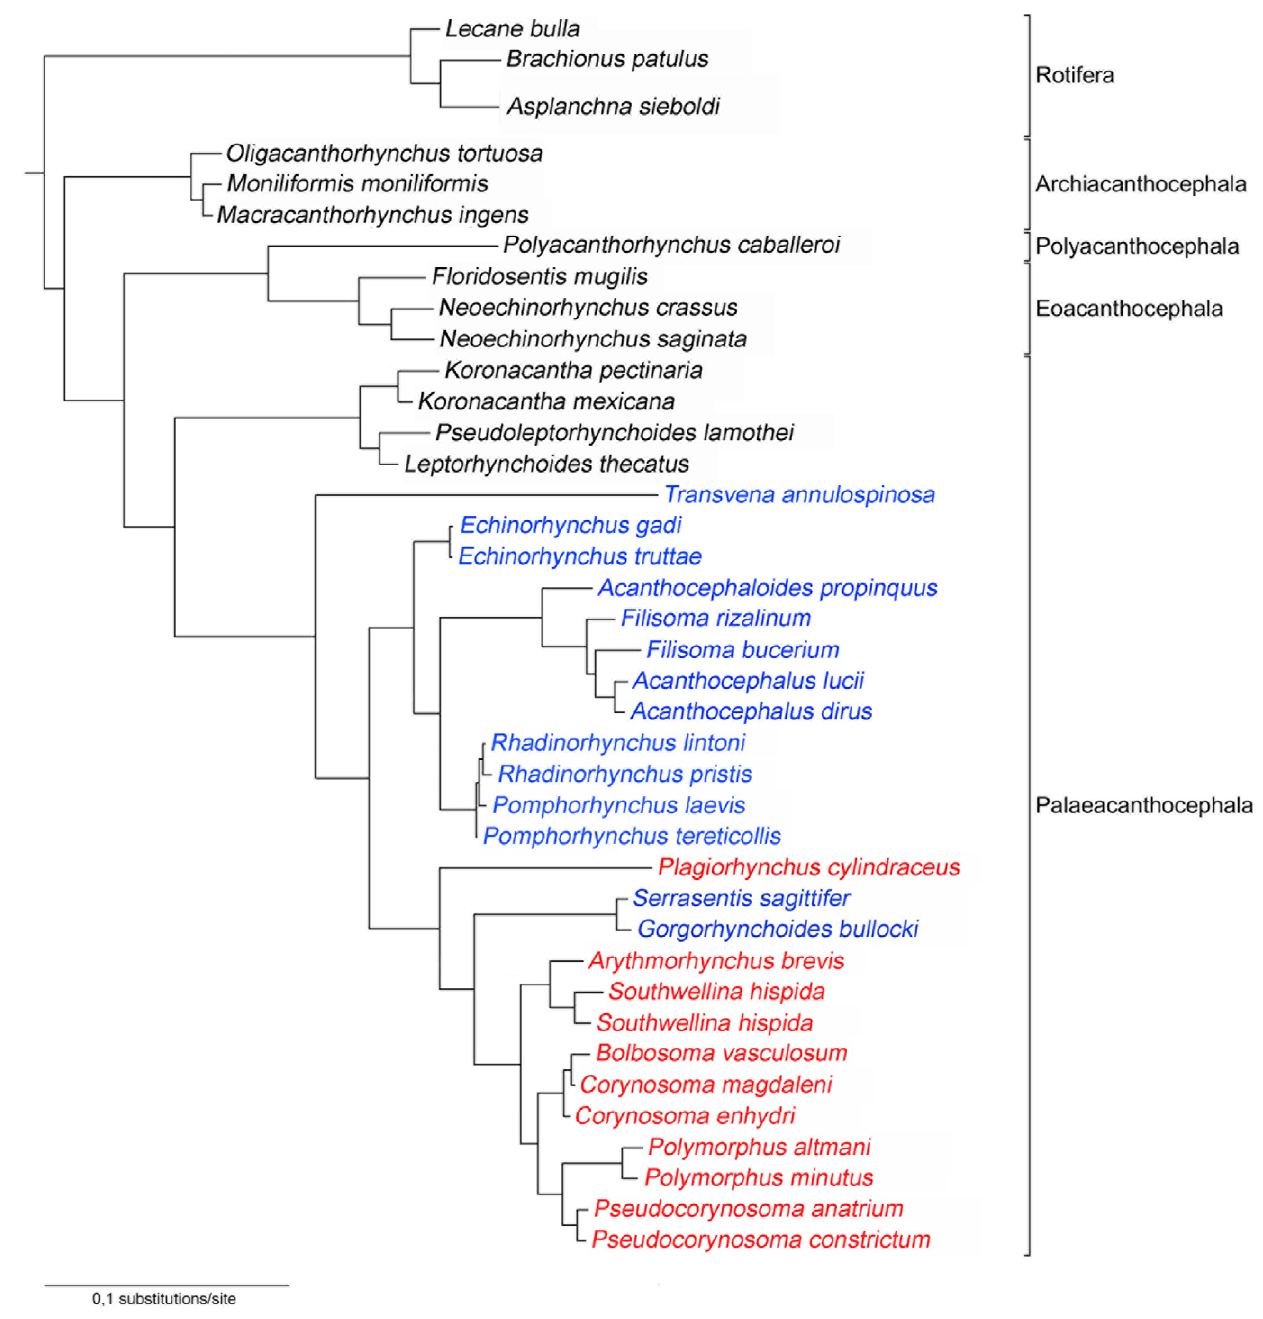
Figure 2. Bayesian consensus phylogram for Acanthocephala relationship based on the SSU rDNA data set. Rotifera is used as outgroup, acanthocephalans are classified as indicated on the right site of the graphic. This tree illustrates the hypothesis that the order Echinorhynchida (blue) and Polymorphida (red) have a paraphyletic arrangement. The branch length scale is the number of substitutions per site.